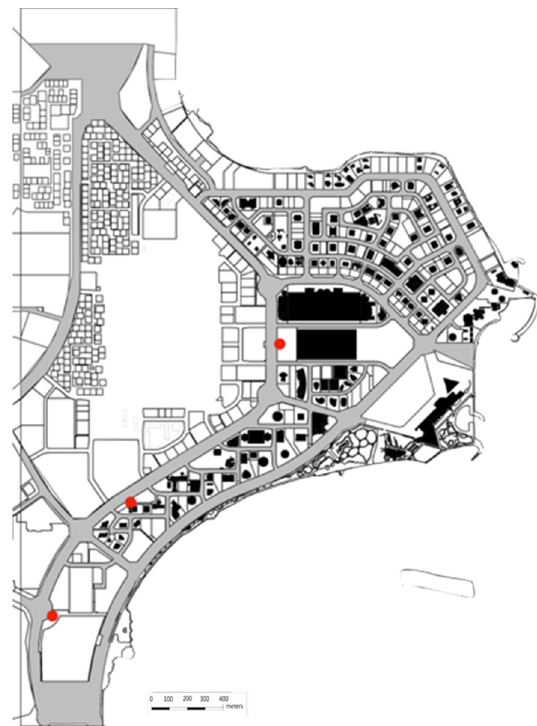
Figure 4. West Bay Doha Built form. Table 1. West Bay Doha population density (source: author, retrieved from planning and statistics authority in Qatar).